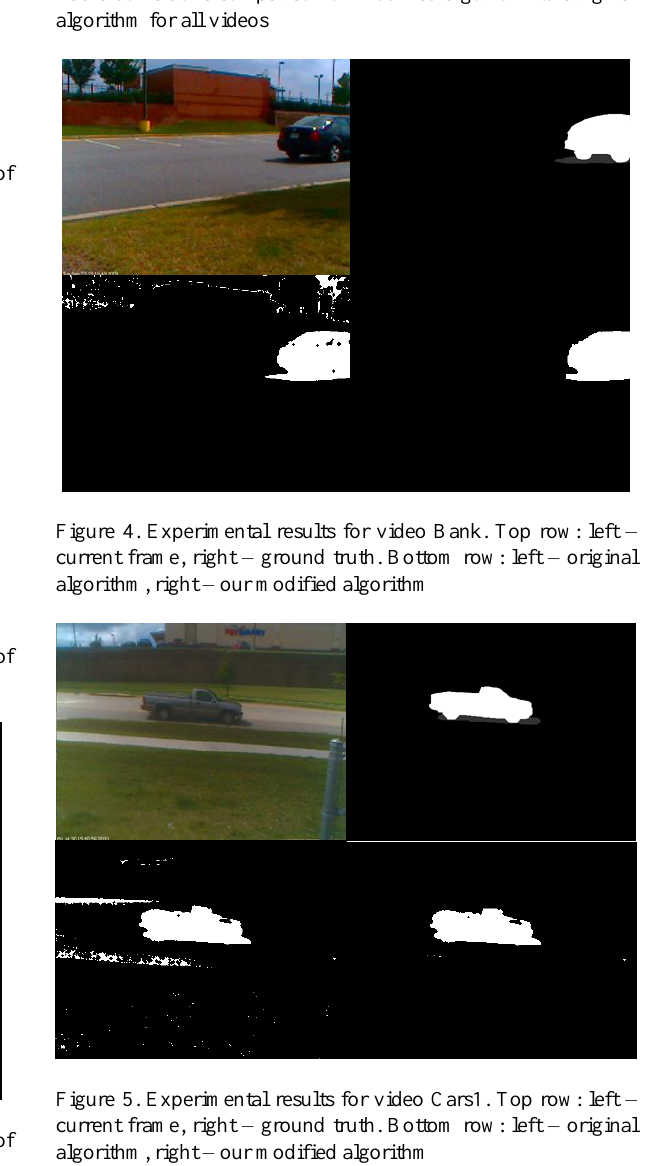
Table 4. Modified algorithm results for each video in terms of metrics